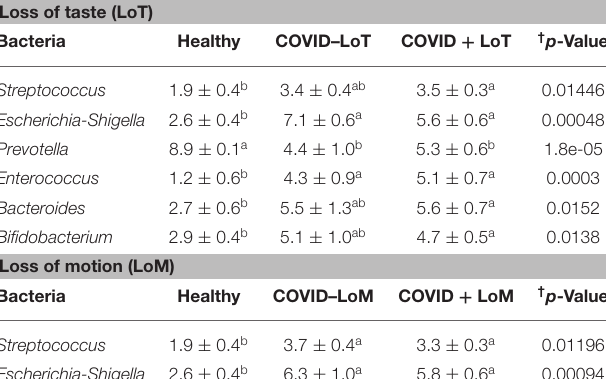
TABLE 1 | Major genera in the gut samples of patients with COVID-19 and healthy controls in response to various clinical conditions.